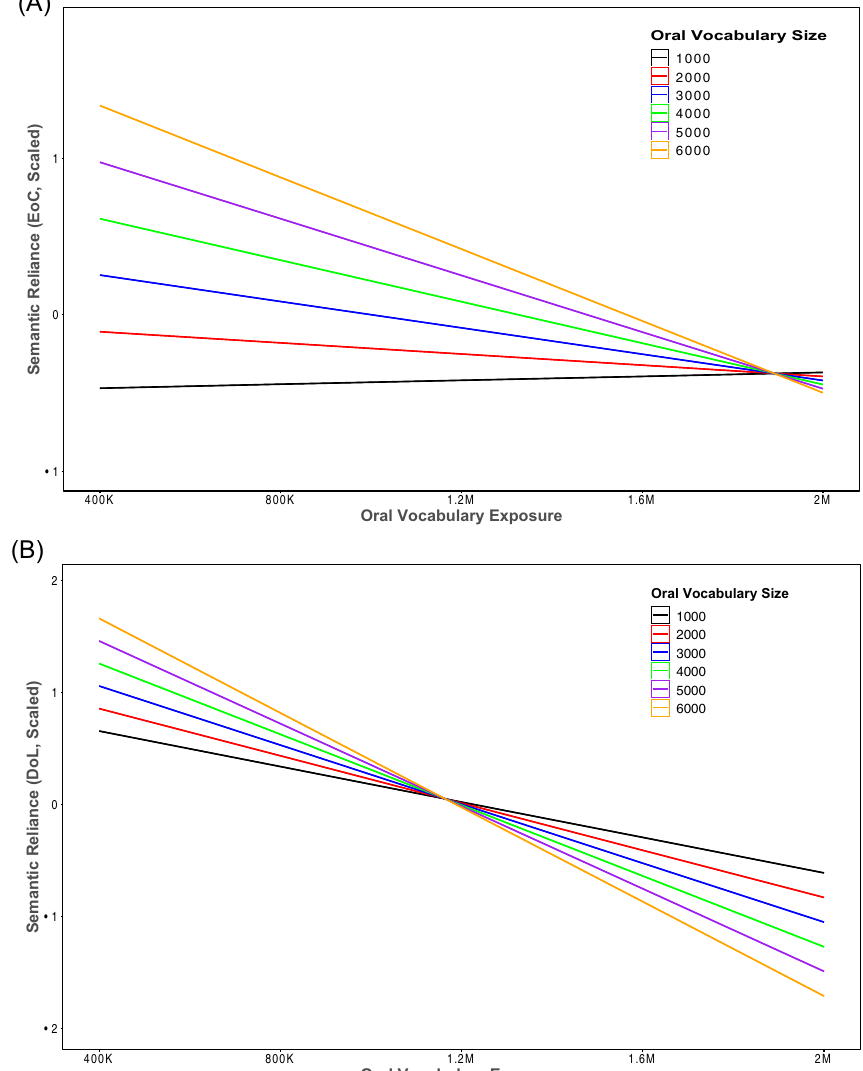
Figure 4. The two-way interaction between oral vocabulary exposure and oral vocabulary size on predicting EoCSR ( A ) or DoLSR ( B ). EoCSR semantic reliance based on the effect of consistency, DoLSR semantic reliance based on the division of